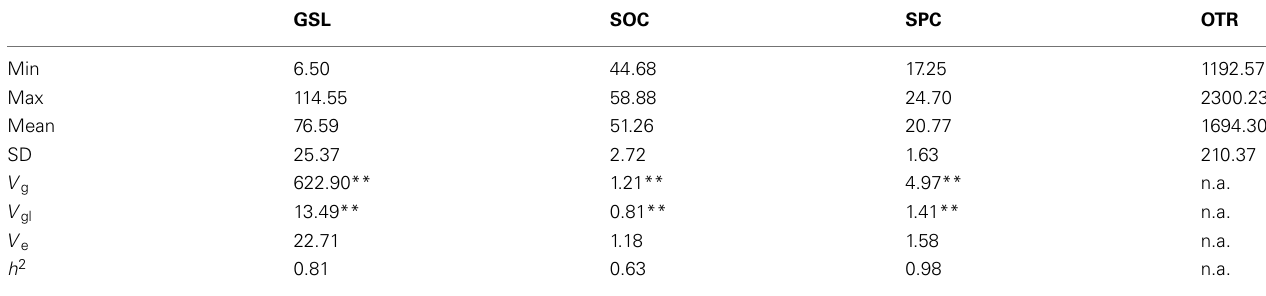
Table 2 | Statistics of the NIRS analysis of 96 B. napus accessions (panel 1) with several parameters (ranges, means, components of variance of genotype, genotype × environment interaction and residual error, and broad sense heritability) of seed glucosinolate ( µ molg − 1 ), protein (%